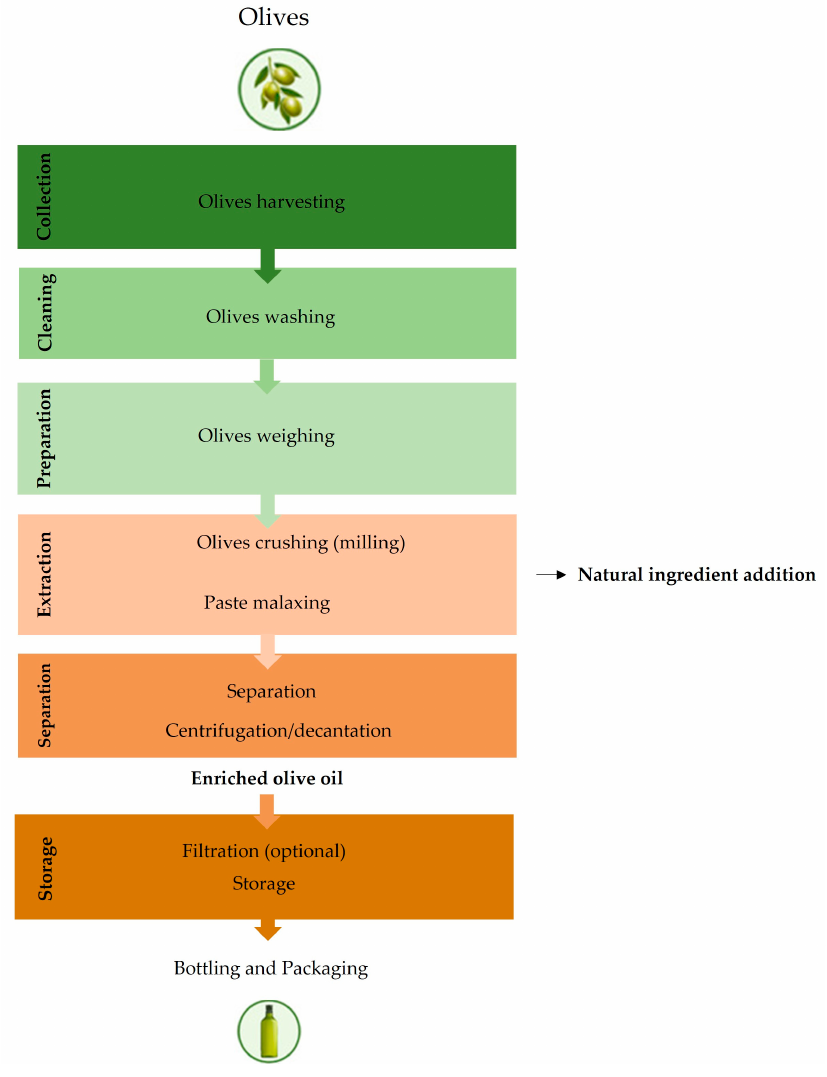
Figure 2. Scheme of enriched olive oil production process, according to merging information found in the literature